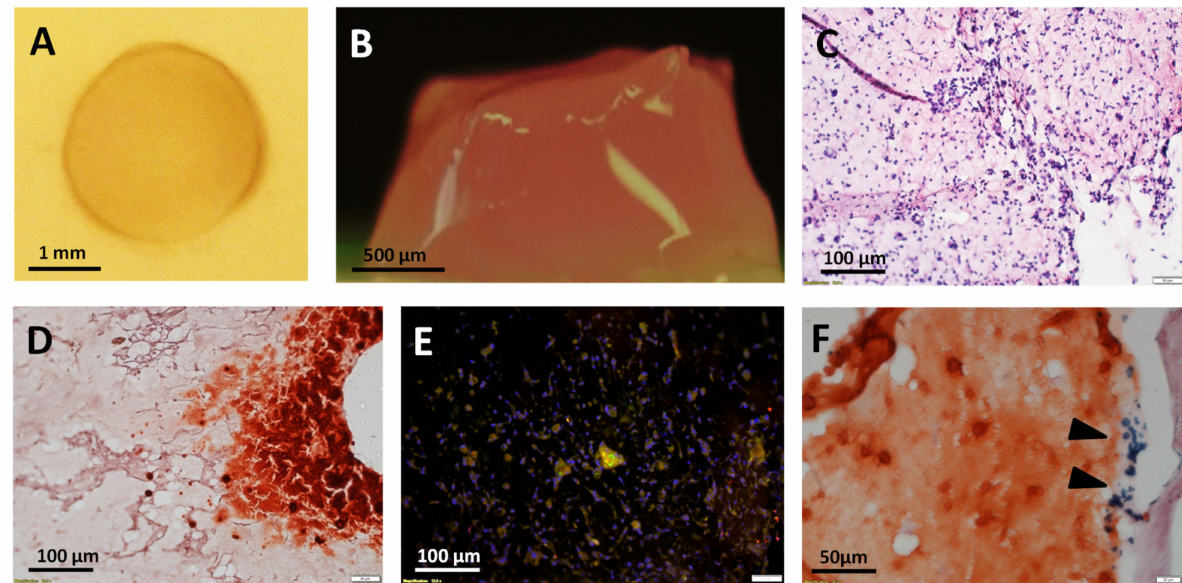
Figure 3. Sonoporation of magnetized 3D tissue constructs. A fibrin-based magnetized 3D tissue construct in top (in cell culture well) and lateral views (( A , B ), respectively). Histological analysis of magnetized tissue, 7 days after sonoporation: hematoxilin and eosin ( C ), Alizarin Red ( D ) and osteocalcin (OCN) immunofluorescent staining ( E ). Nuclear staining (DAPI) and OCN staining are shown in blue and green, respectively. In Alizarin Red, clusters of MNPs were sporadically observed, as a result of aggregation (black arrows, ( F